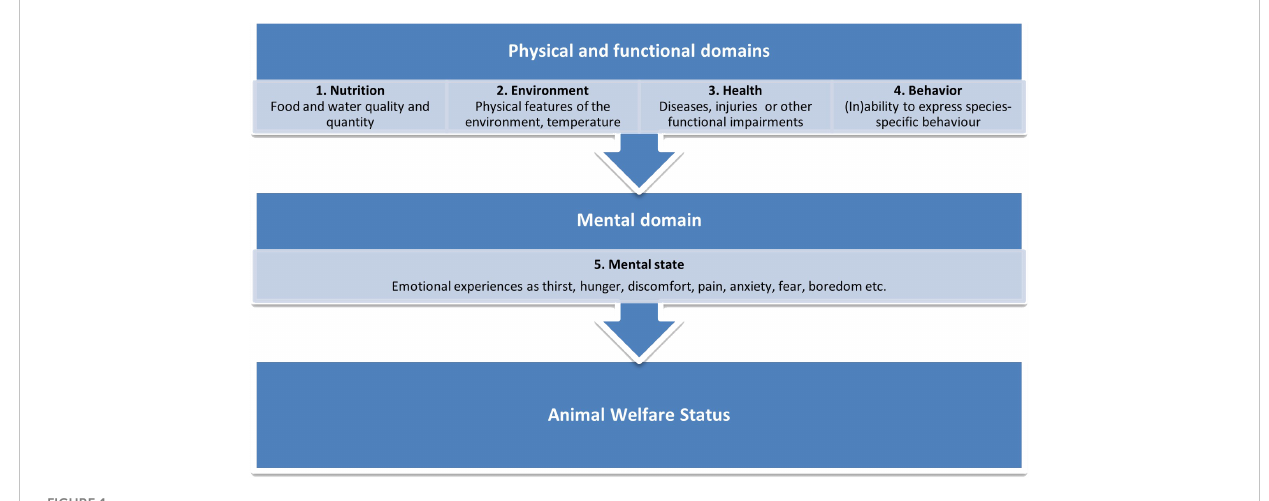
FIGURE 1 The Five Domains Model. The four physical and functional domains, i.e., nutrition, environment, health, and behavior, affect the emotional experience of the animal, i.e. the fi fth domain, and together the fi ve domains de fi ne the animal ’ s welfare status (Mellor et al., 2009; Mellor and Beausoleil, 2015; Mellor,